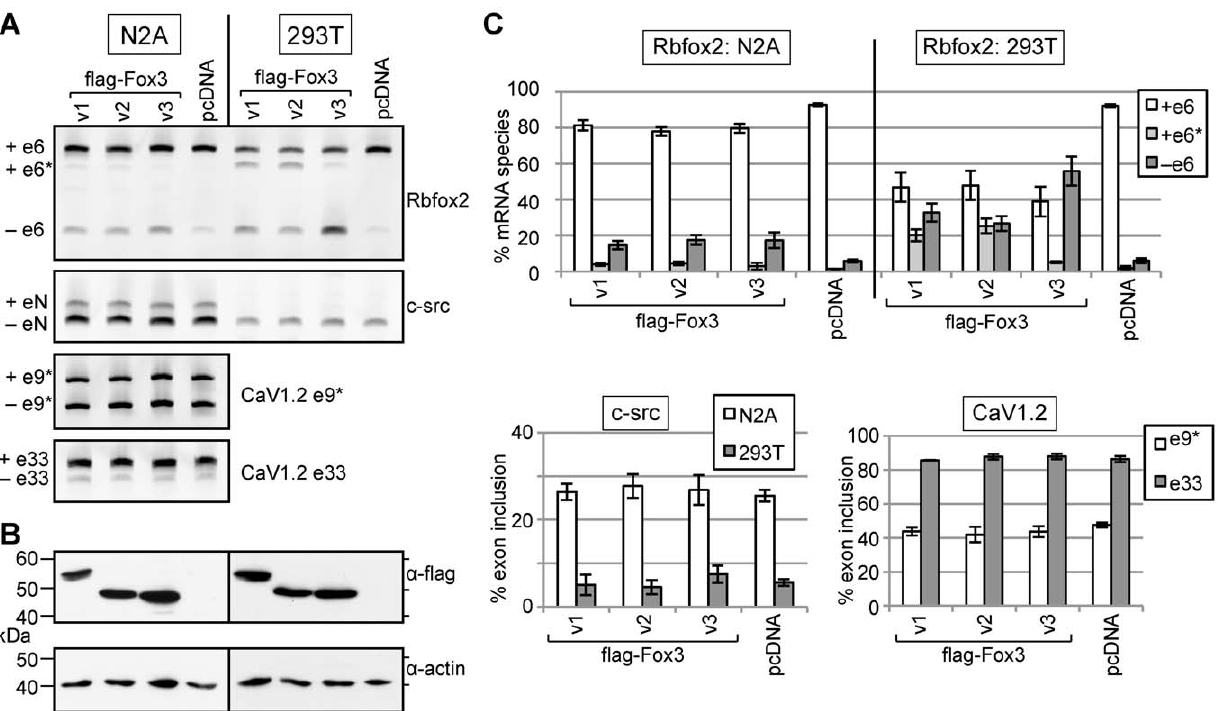
Figure 5. Rbfox3 variants all function to regulate alternative splicing, irrespective of steady-state sub-cellular localization. N2A or 293T cells were transiently transfected with Rbfox3 variants 1, 2 or 3 harboring N-terminal flag-tags, or pcDNA3 vector control. A. Alternative splicing of endogenous mRNAs encoding Rbfox2, c-src and CaV1.2 (alternative exons 9* and 33) was assayed by RT-PCR. Rbfox2 + e6* represents splicing from exon 5 to a cryptic exon downstream of exon 6. B. Western with anti-flag was used to confirm Rbfox3 overexpression, and anti-actin was used as a loading control. C. Quantification of the results shown in A and 2 additional experiments (i.e. n=3); results are displayed as average + / 2 standard deviation. All Rbfox3 variants promoted skipping of Rbfox2 exon 6, but no change was seen in the splicing of c-src exon N or CaV1.2 exons 9* or 33 upon Rbfox3 overexpression. derived from Rbfox2 intron 5 that we have called exon 5* (Figure 6). Emetine treatment increases the abundance of transcripts containing either of these cryptic exons from 5% to 17% in cells expressing Fox3v1, from 6% to 17% for Fox3v2, and from 4% to 8% for Fox3v3. Inclusion of either exon 6* or exon 5* (which is 41 nt) alters the reading frame of the mRNA introducing two premature termination codons in the downstream exon, exon 7, as depicted in Figure 6D. Thus our data shows that Rbfox3 regulates alternative splicing of Rbfox2 to enhance the production of mRNA species that are targeted for NMD. This is likely to be a phylogenetically conserved mechanism of Fox family autoregula- tion since both of these cryptic exons and their splice sites are highly conserved amongst mammals, and in birds as shown in Figure 6E.